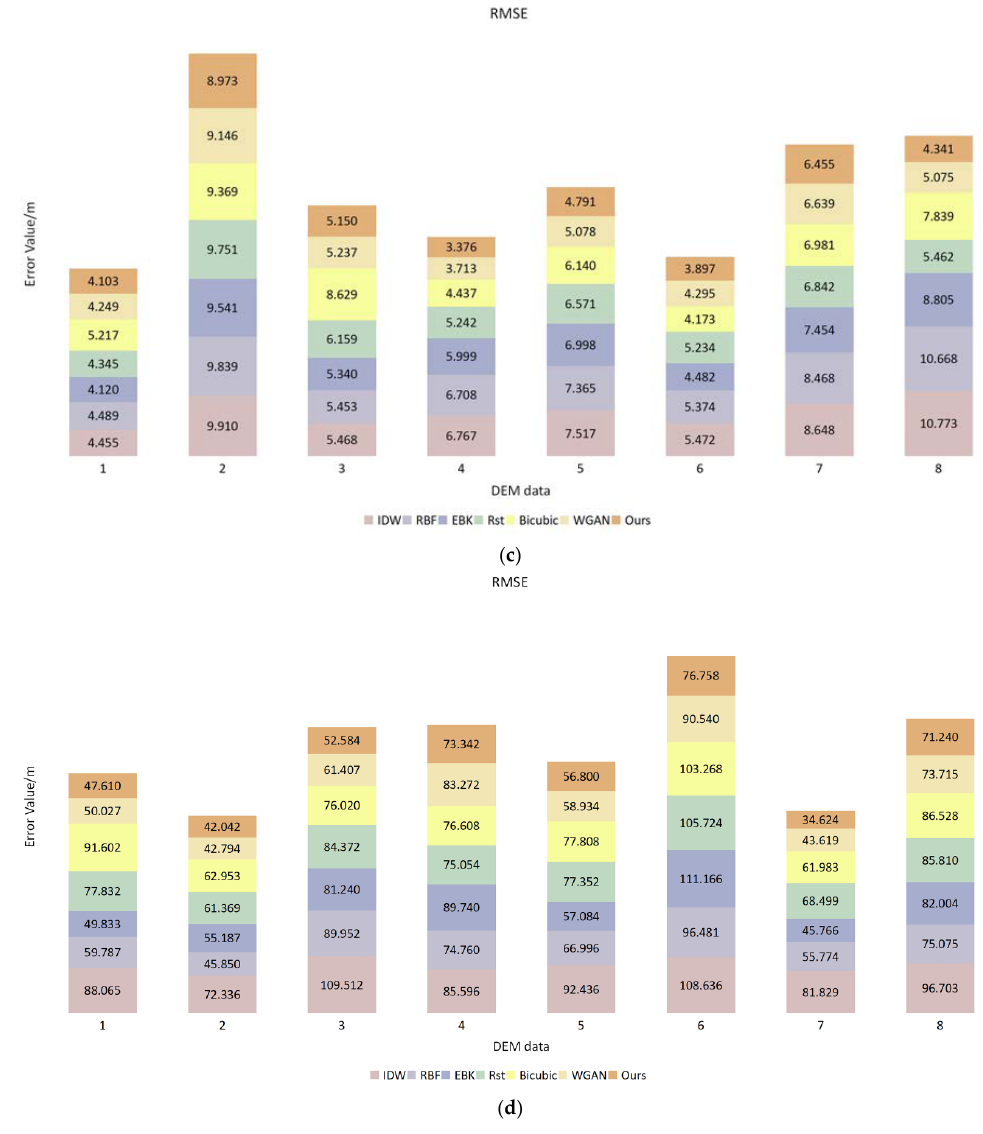
Figure 11. The root-mean-square error. ( a ) Test data for Norway (gentle terrain); ( b ) test data for Norway (complex terrain); ( c ) verification data of a place in Jiangsu province; and ( d ) verification data of a place in Sichuan province.